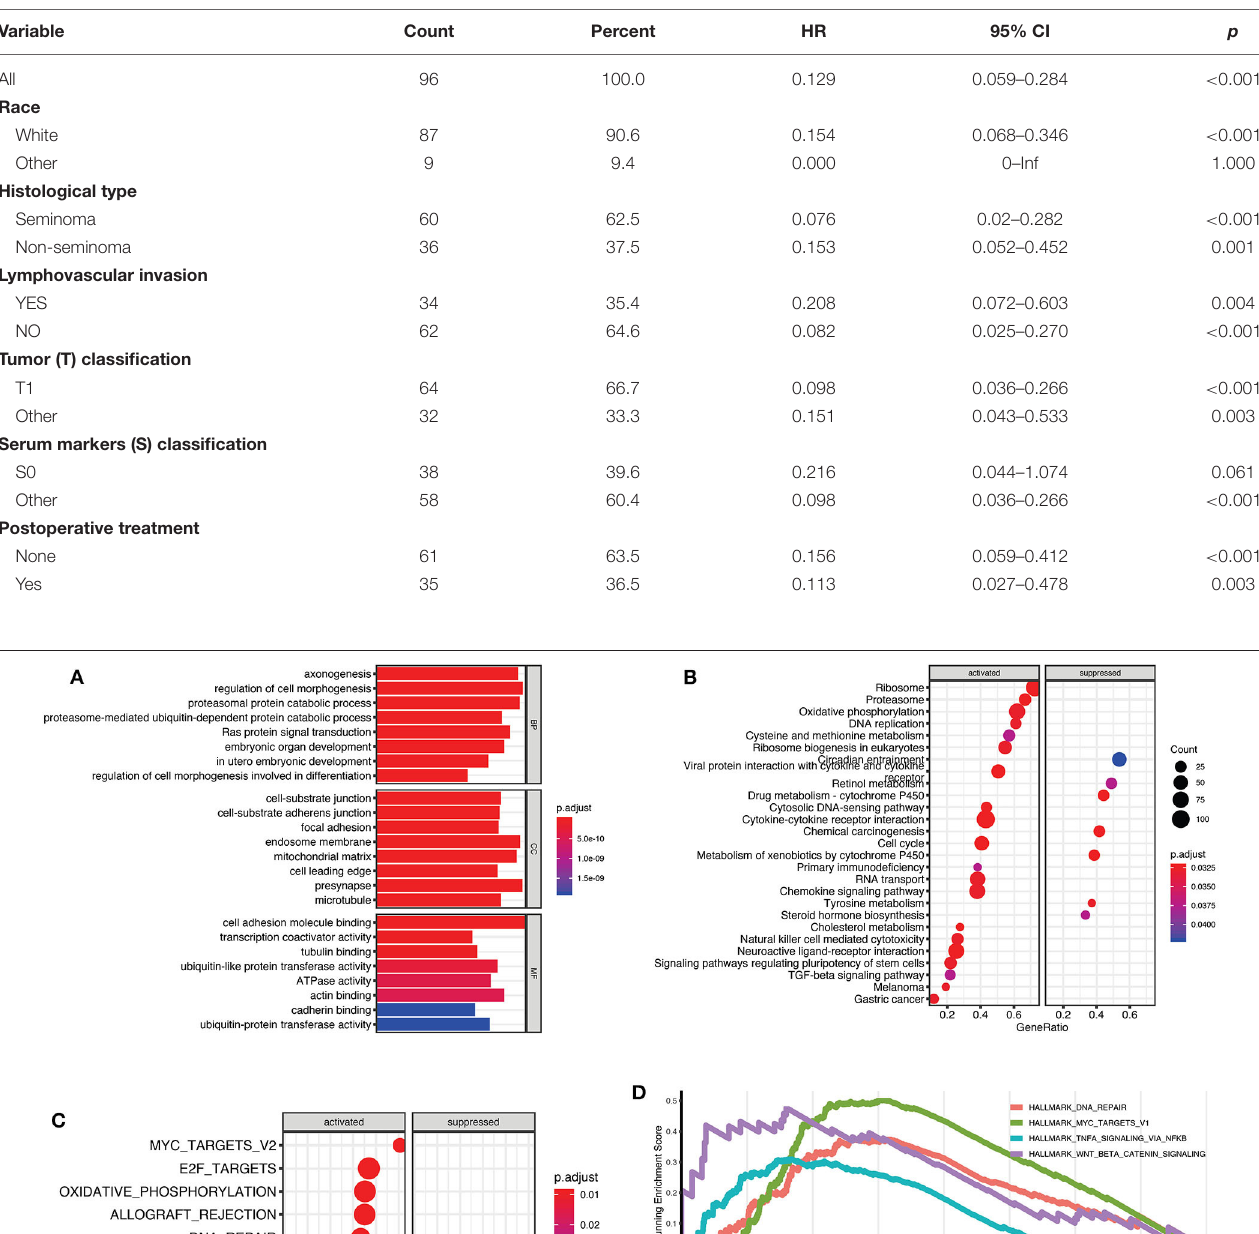
Frontiers in Oncology |